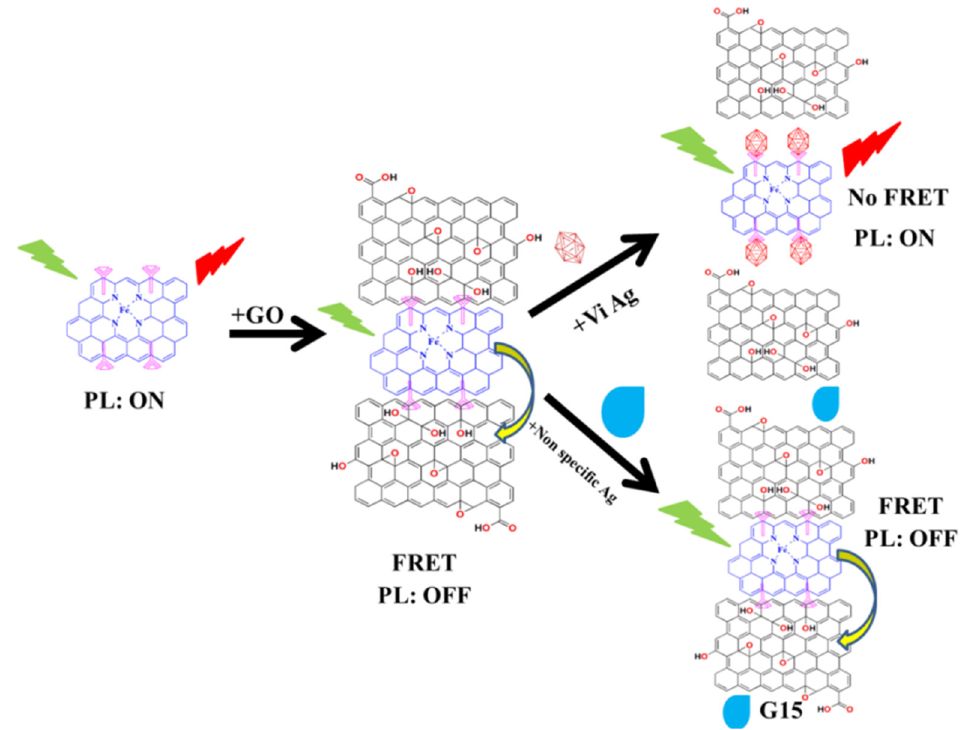
Figure 17. Plausible FRET mechanism for the Fe-N-GQDs/GO-composite (donor/acceptor) and its fluorescence responses. Reprinted from [72] with permission from Elsevier.